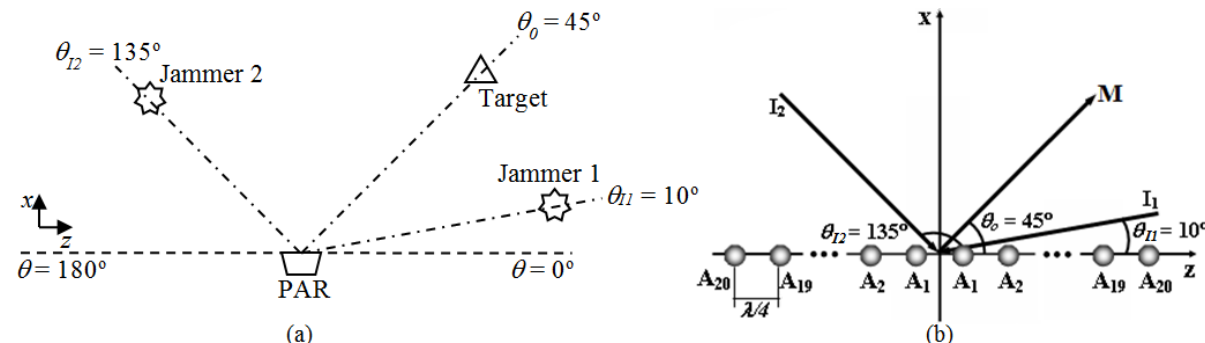
= 45°, θ = 10° and 0 I1